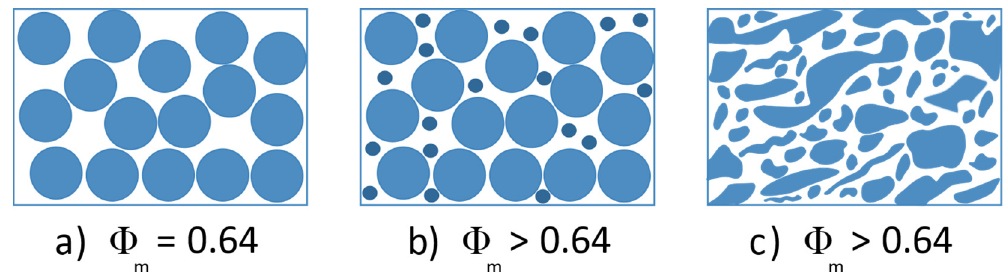
Figure 2. Scheme of di ff erent morphologies with the corresponding maximal packing fraction Φ m that can be expected. ( a ) monodispersed spherical system, ( b ) bimodal spherical system, ( c ) broad distribution of ellipsoid shape system.